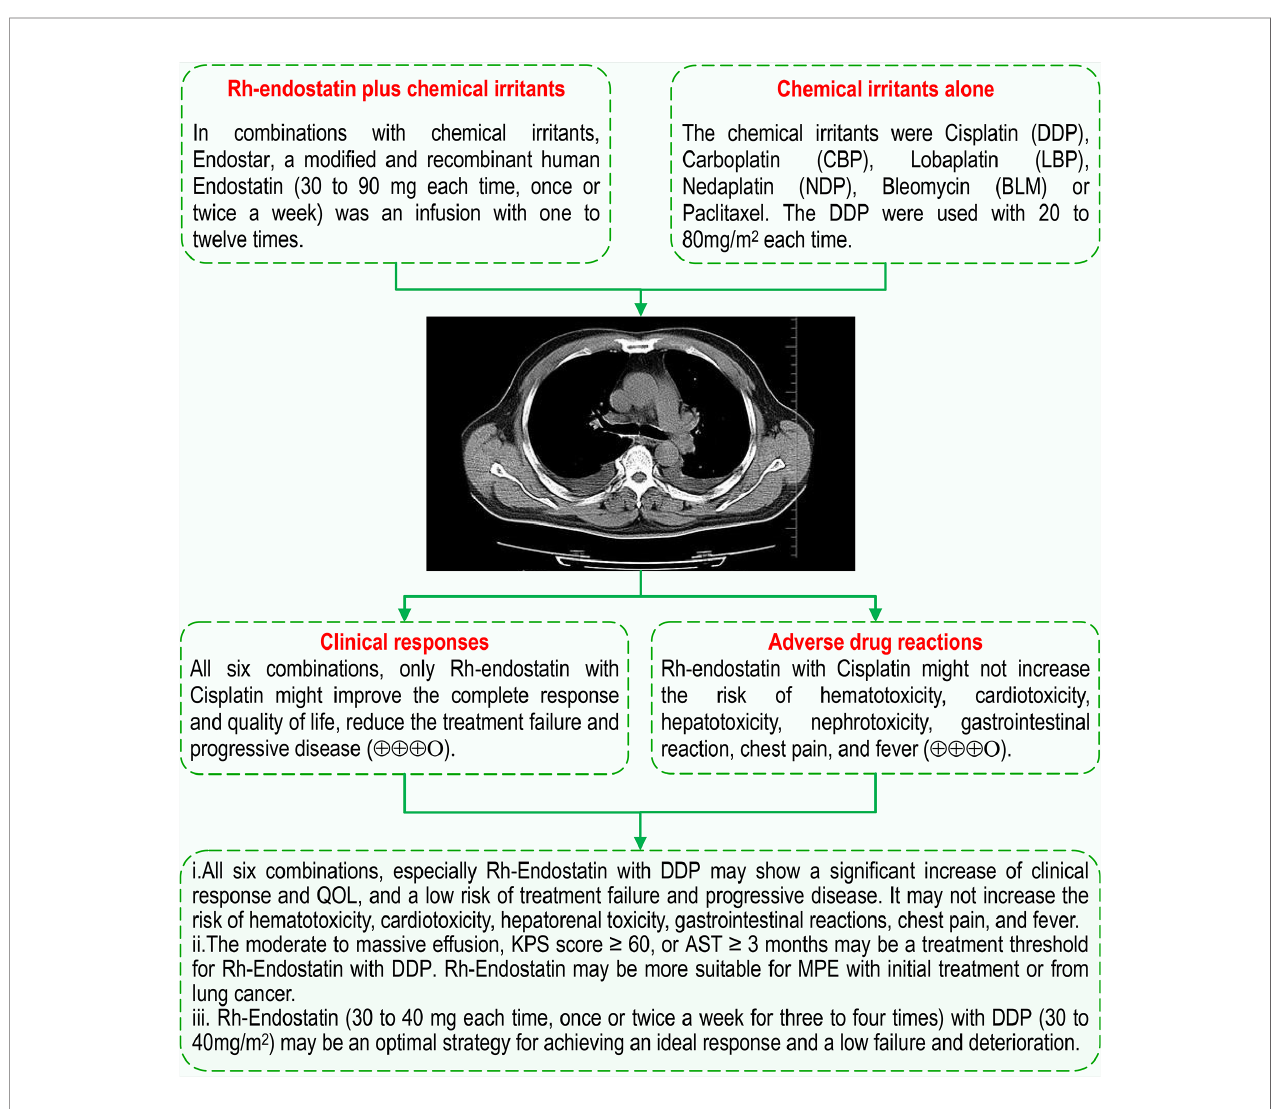
FIGURE 7 | Intrapleural infusion with Rh-endostatin for MPE. AST, anticipated survival time, QOL, quality of life; KPS, Karnofsky Performance Status; MPE, malignant pleural